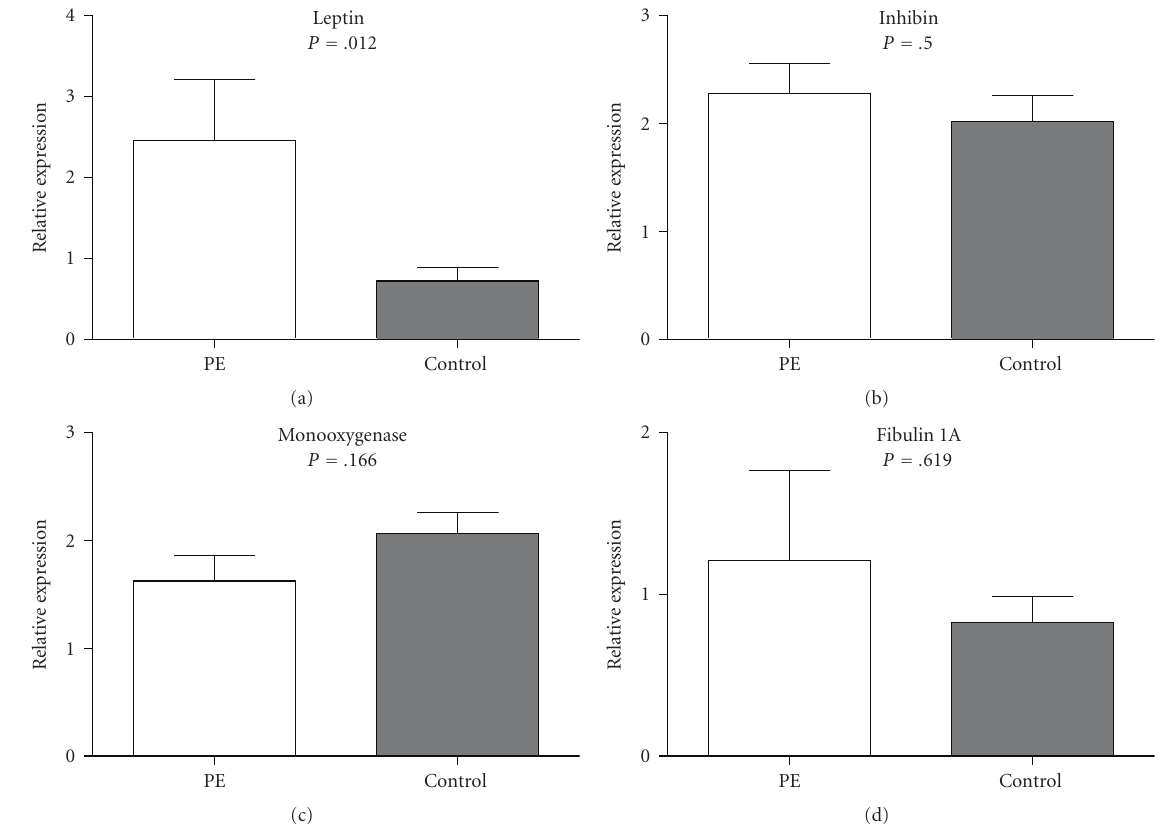
Figure 2: The expression patterns of the sequences as determined by real-time PCR. White bars represent pre-eclampsia cases; grey bars represent controls. Each bar represents the mean (+SEM) relative expression of the individual samples in the experiment. P - values for comparisons between cases and controls were: Fibulin (.619; FC 1.46), leptin (.012; FC 3.41), inhibin (.500; FC 1.13), tyr 3- monooxygenase/tryp 5-monooxygenase activation protein ε ( P = . 166; FC − 1 . 27); Mann-Whitney test. (Pre-eclampsia cases: n = 9, controls: n = 12; one control placenta was found to have a cDNA yield which was significantly lower than the other samples and it was therefore excluded from the subsequent